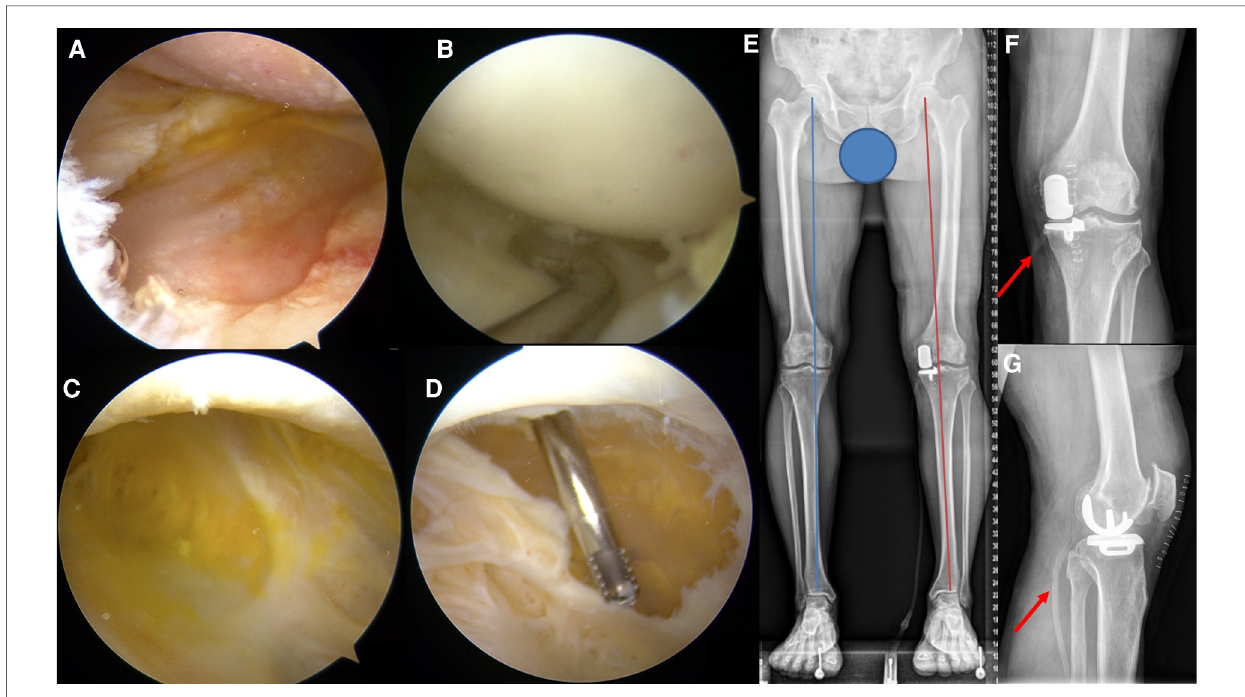
FIGURE 2 Arthroscopic surgery view ( A – D ) and immediate postoperative X-ray ( E – G ) evaluation after the surgery. ( A ) Severe cartilage wearing of the medial femoral and tibial condyles. ( B ) Normal lateral meniscus and cartilage of the femoral and tibial condyles. ( C ) The wall of the popliteal cyst is fi lled with orange juice- like fl uid. ( D ) Resection of the cyst wall. ( E ) The Weight-Bearing line (red) of the left lower extremity returned to a normal position similar to the contralateral side (blue). ( F,G ) Long red arrows indicated the drainage